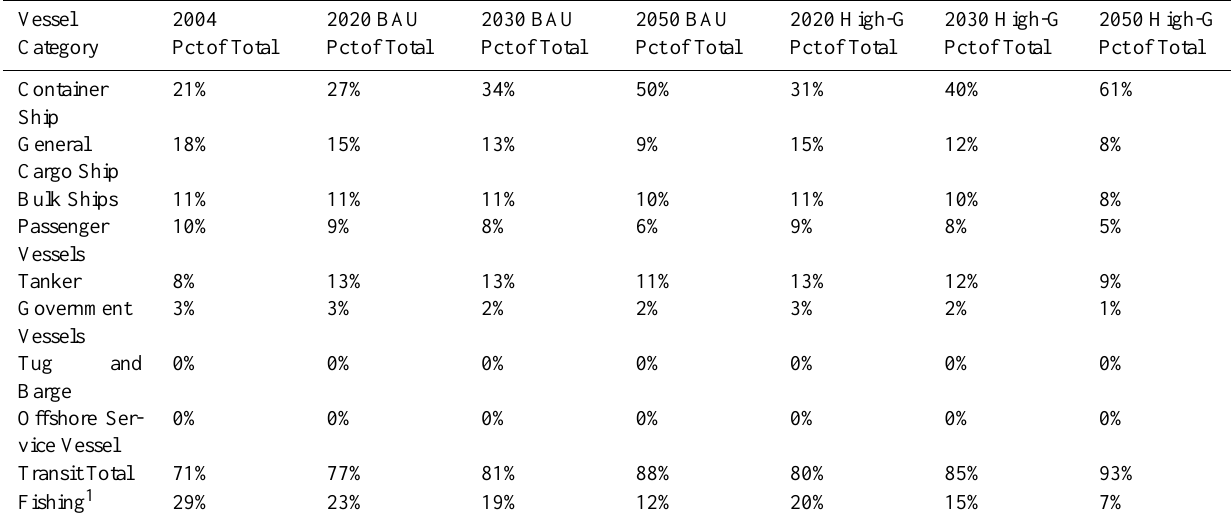
Table 7. In-Arctic shipping emissions by vessel type across future